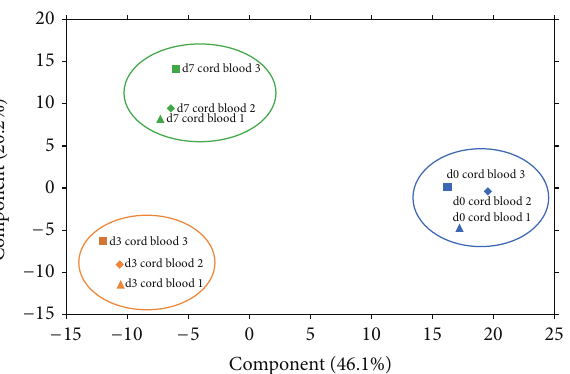
Figure 1: Umbilical cord blood cells were enriched by MACS and sorted for CD34 high /CD45 low -expression.